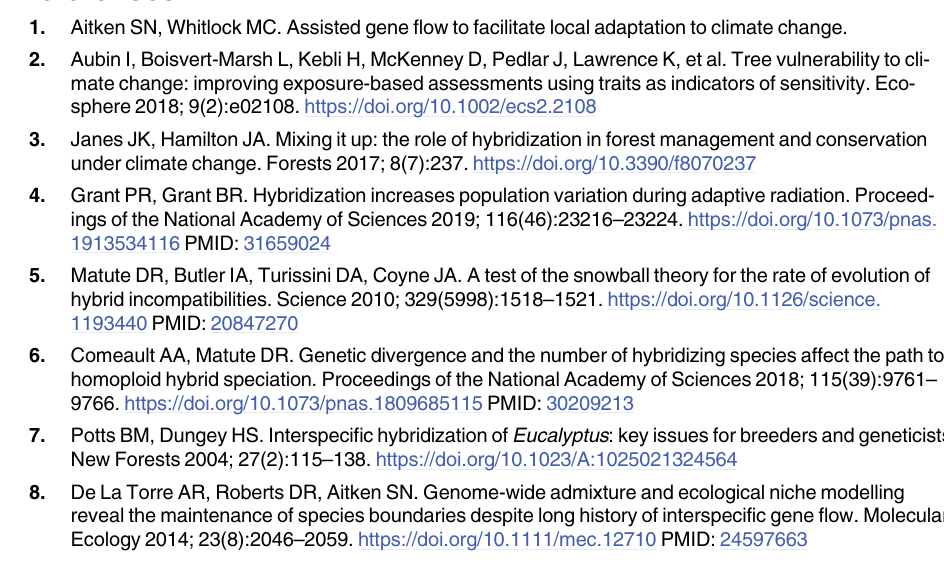
S4 Fig. Graphical interpretation regarding the ordinal logistic regression for origin of father to explain attack severity (A00). S5 Fig. Graphical interpretation regarding the ordinal logistic regression for origin of mother to explain egg puncture occurrence (E00). S6 Fig. Graphical interpretation regarding the ordinal logistic regression for origin of father to explain egg puncture occurrence